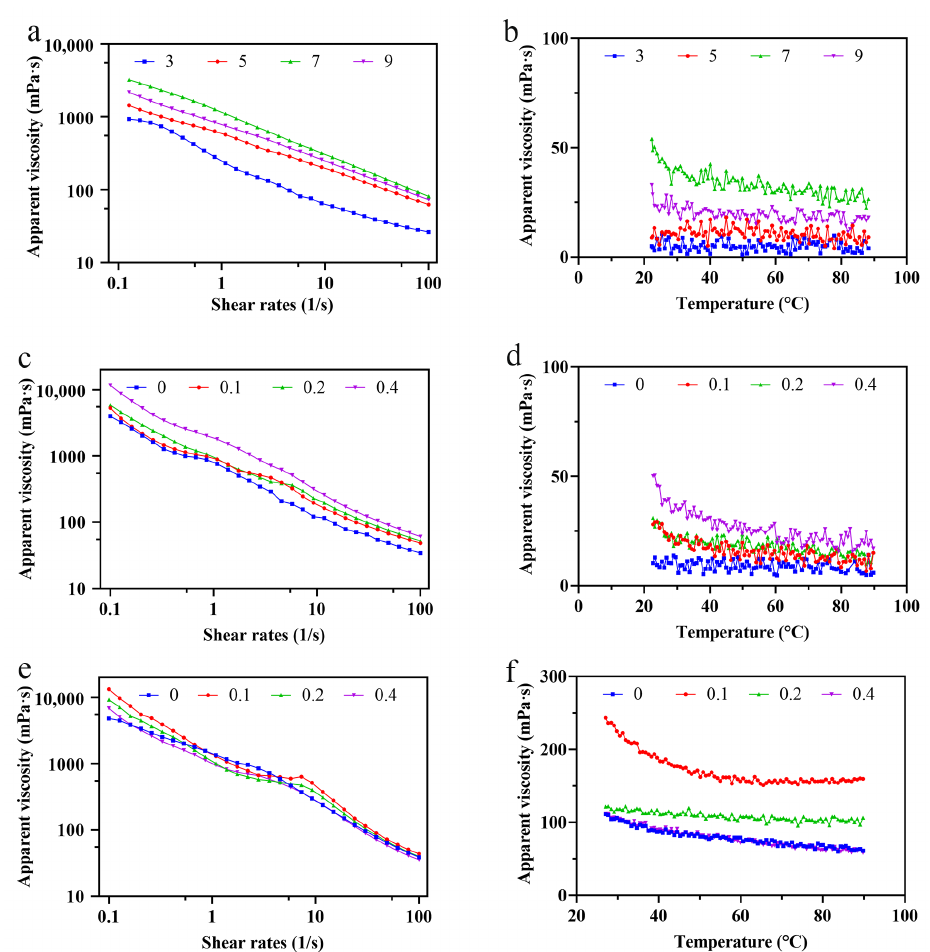
Figure 3. The apparent viscosity dependence of LSEP solutions on shear rates at different pH ( a ), CaCl 2 concentration ( c ), and NaCl concentration ( e ); the apparent viscosity dependence of LSEP solutions on temperature at different pH ( b ), CaCl 2 concentration ( d ), and NaCl concentration ( f